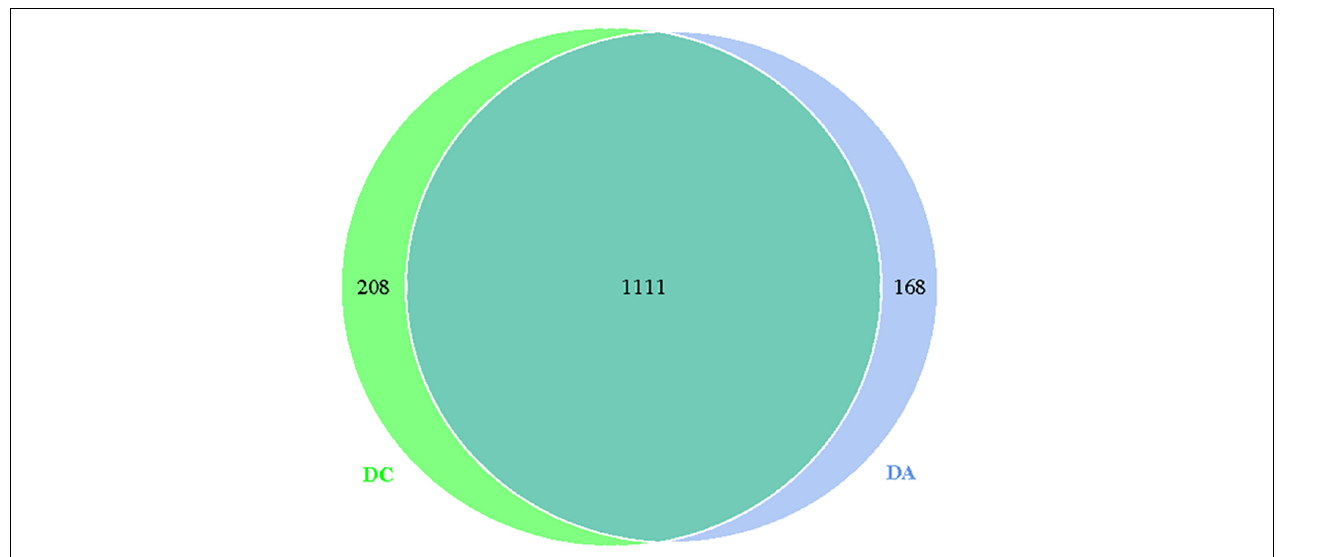
FIGURE 1 | The OUT Wayne